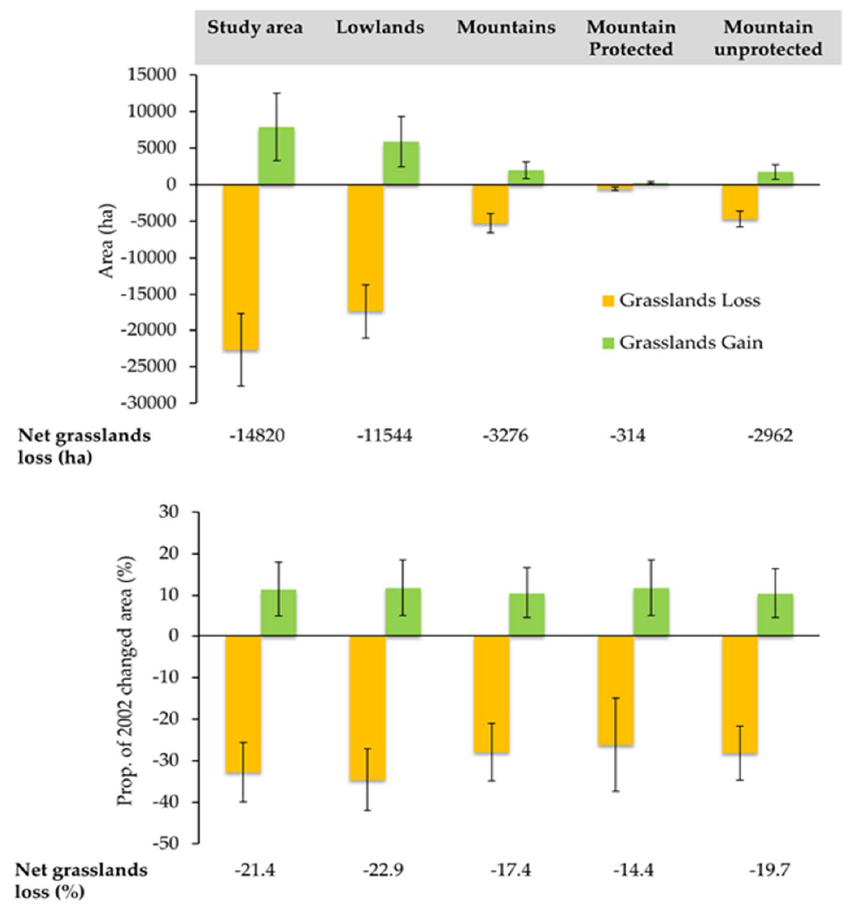
Figure 5. Total estimated areas of grassland cover change with confidence intervals over the transboundary study area of Peneda – Gerês and for the different extents of analysis: lowlands and mountains, mountains protected and unprotected. In the upper panel, absolute area. Lower panel, proportional change relative to the initial 2002 grassland cover areas (e.g., grassland loss in the study area is equivalent to approximately 32.8% of grassland area in 2002). Error bars indicate 95% confidence intervals based on the standard errors derived from the error matrix. Table 2. Total estimated bias-corrected areas for the stable grasslands and no grasslands classes with margin of error at the 95% confidence level (ha) at all extents of analysis: study area, lowlands and mountain domains, protected and unprotected mountain governance extents. The standard error and the 95% bias-corrected areas (ha) were derived from the error matrix according to the good practices protocol of Olofsson et al. [22].